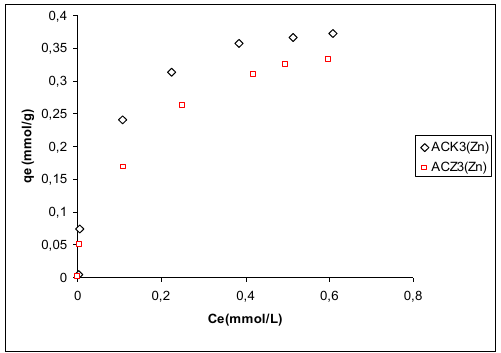
Figure 3. Monocomponent isotherm of Zn(II) onto ACK2 and ACZ2.